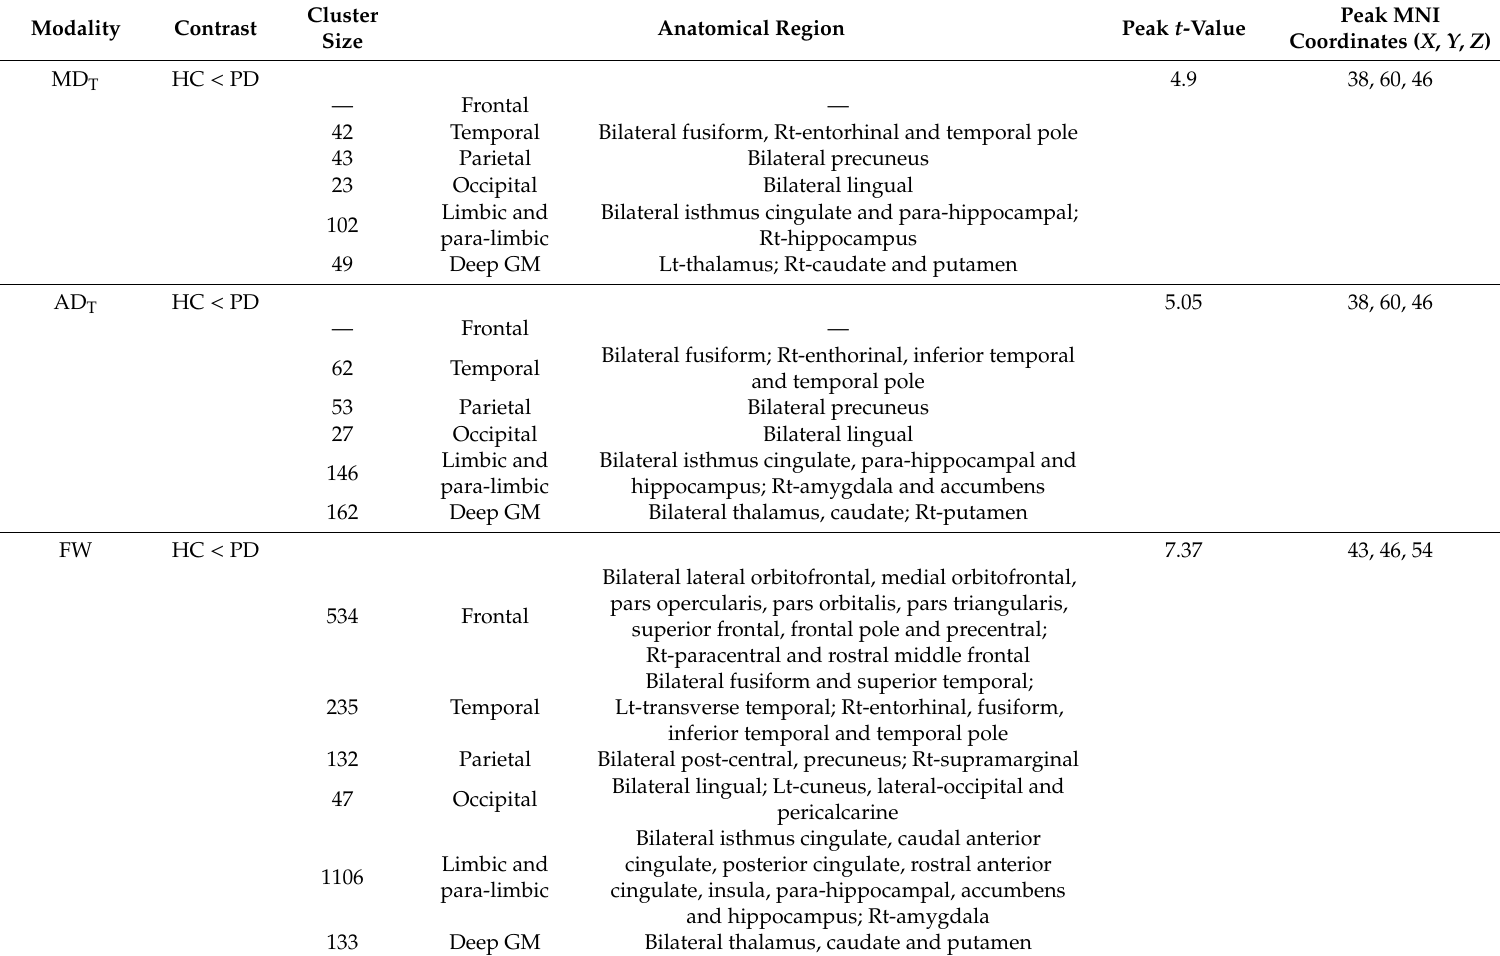
Lt, left; Rt, right; AD T , free water-corrected axial di ff usivity; FW, free water; GM, gray matter; HC, healthy controls; MD T , free water-corrected mean di ff usivity; PD, Parkinson’s